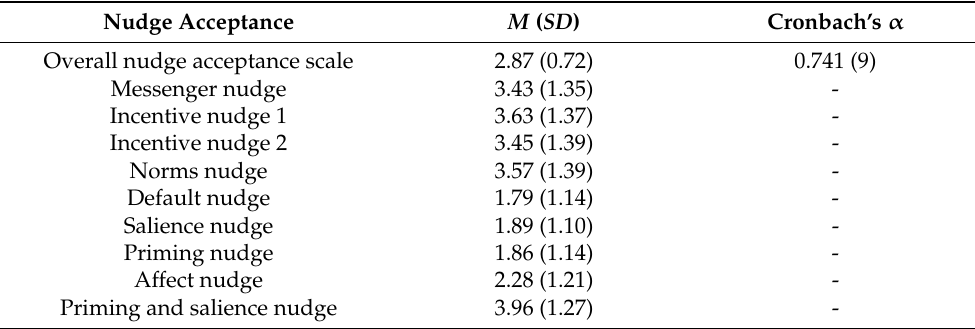
Table 1. Descriptive statistics of nudge acceptance.